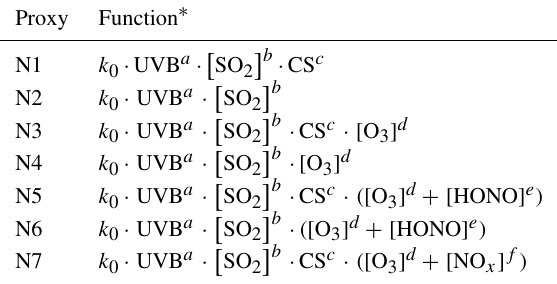
Table 3. Proxy functions for the nonlinear fitting